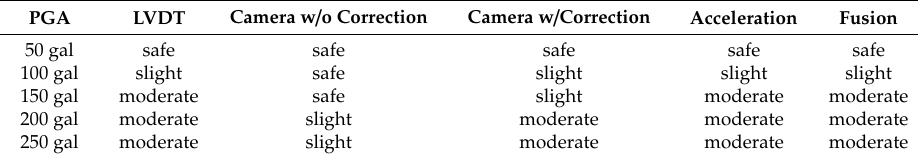
Table 2. Estimated damage levels after the five earthquake